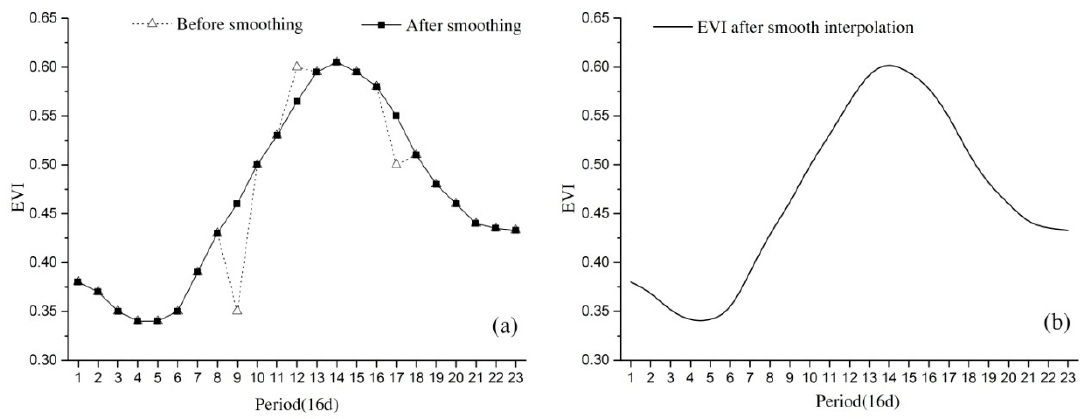
Figure 2. The EVI time series data before ( a ) and after ( b ) HANTS processing.